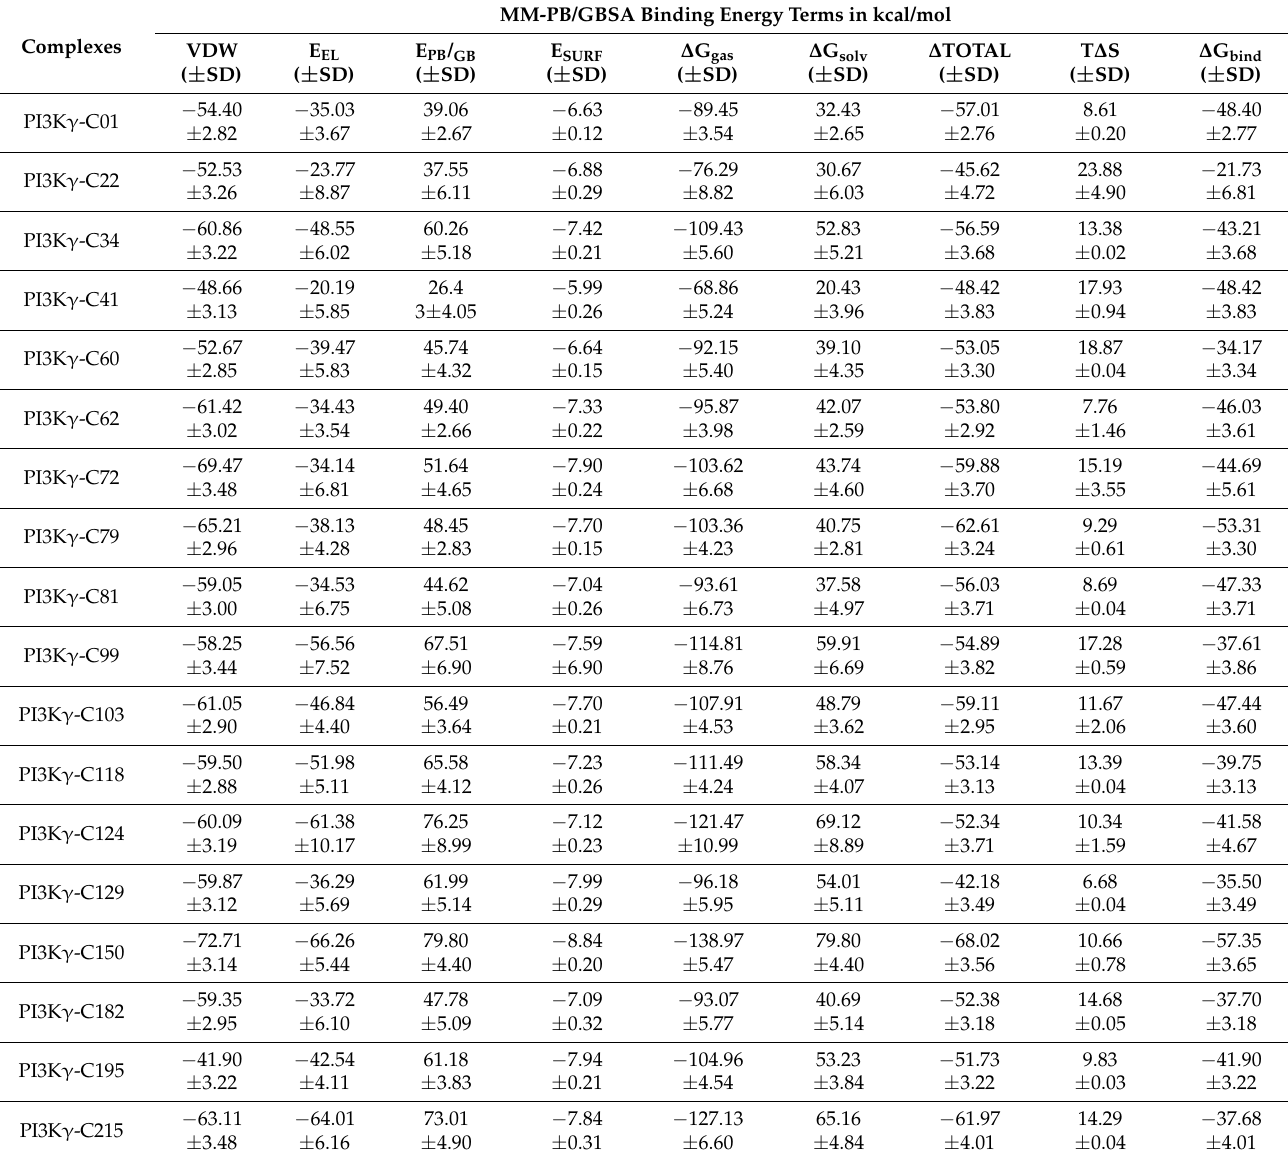
Table 2. Binding energy calculation of the selected compounds in complex with PI3K γ